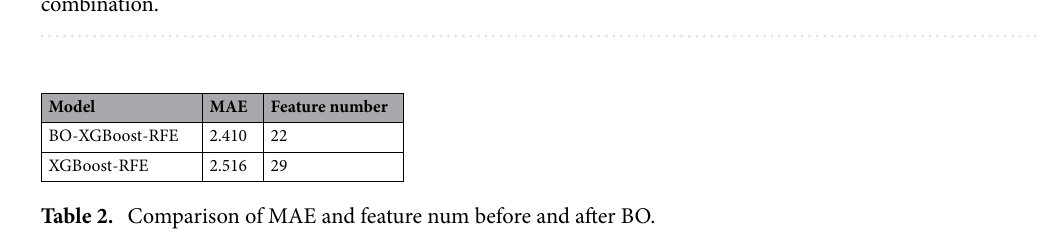
Table 2. Comparison of MAE and feature num before and after